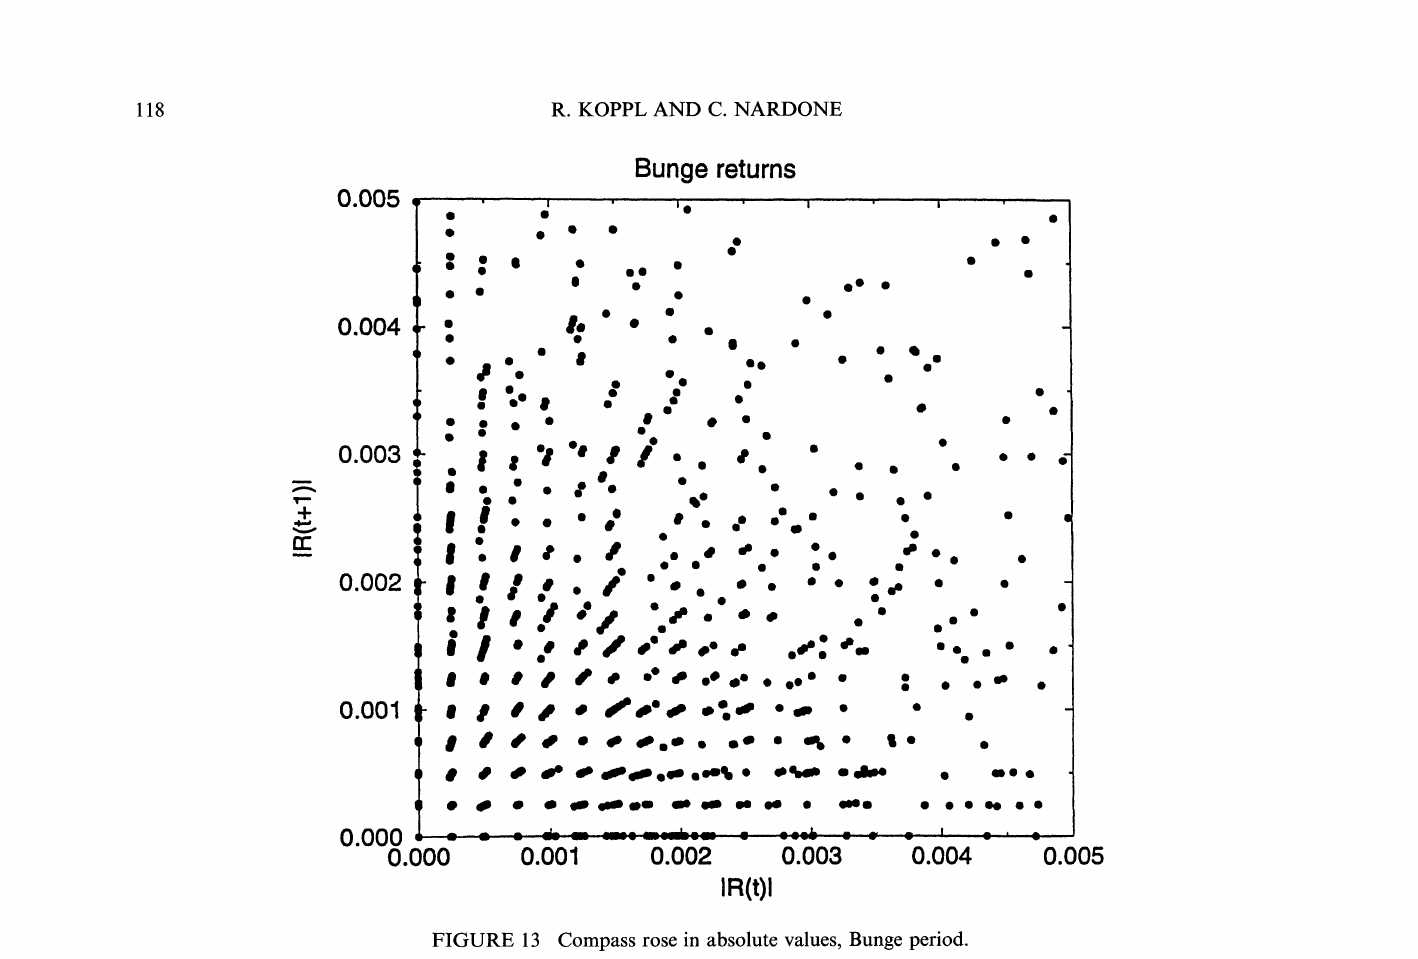
FIGURE 13 Compass rose in absolute values, Bunge